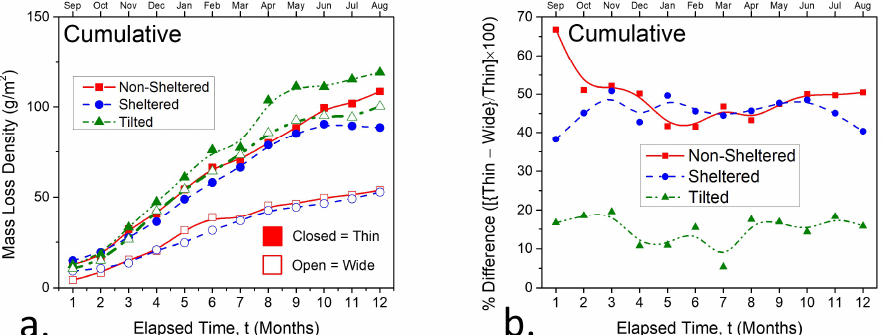
Figure 4. Mass Loss Density Results for the Thin steel reported for each condition. Non-Sheltered ( a ); Sheltered ( b ); Tilted ( c ); Overlay of all Thin cumulative results ( d ). Figure 5 provides a perspective on the effect of Wide vs. Thin steel. Comparing equiv-